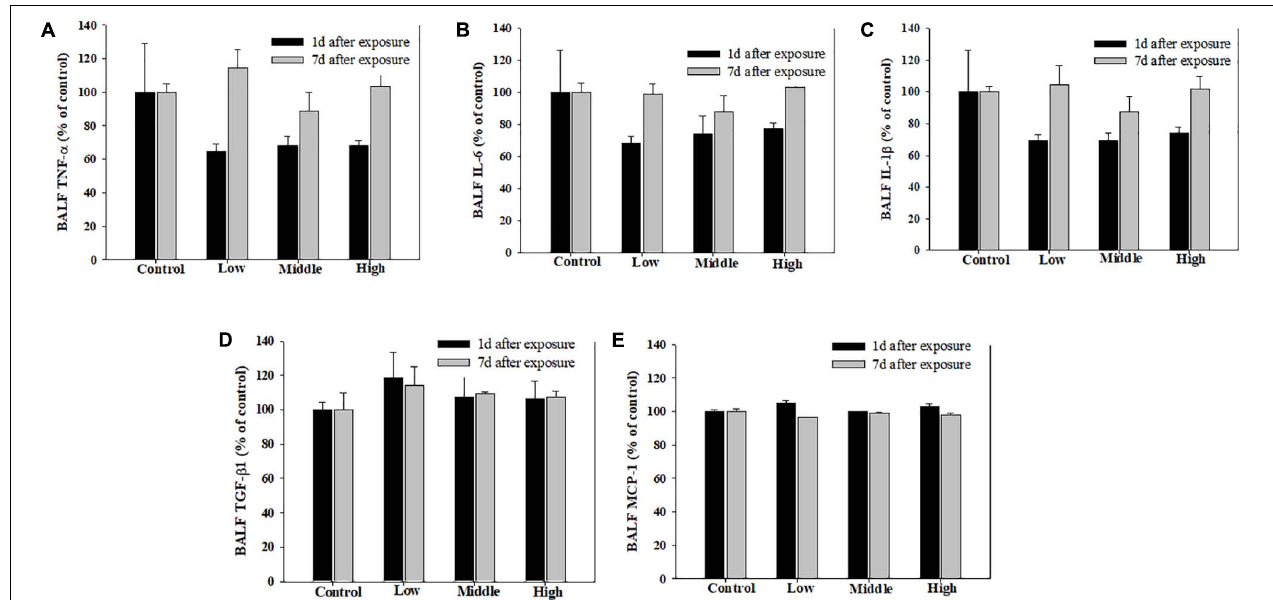
FIGURE 5 | Pulmonary inflammation induced by repeated inhalation of the SM in rats. (A) Tumor necrosis factor-alpha (TNF- α ), (B) interleukin-6 (IL-6), (C) interleukin-1beta (IL-1 β ), (D) transforming growth factor-beta1 (TGF- β 1), (E) monocyte chemoattractant protein-1 (MCP-1) in BALF. Male rats inhaled aerosolic SM for 2 weeks. The values are reported as the mean ± SE.